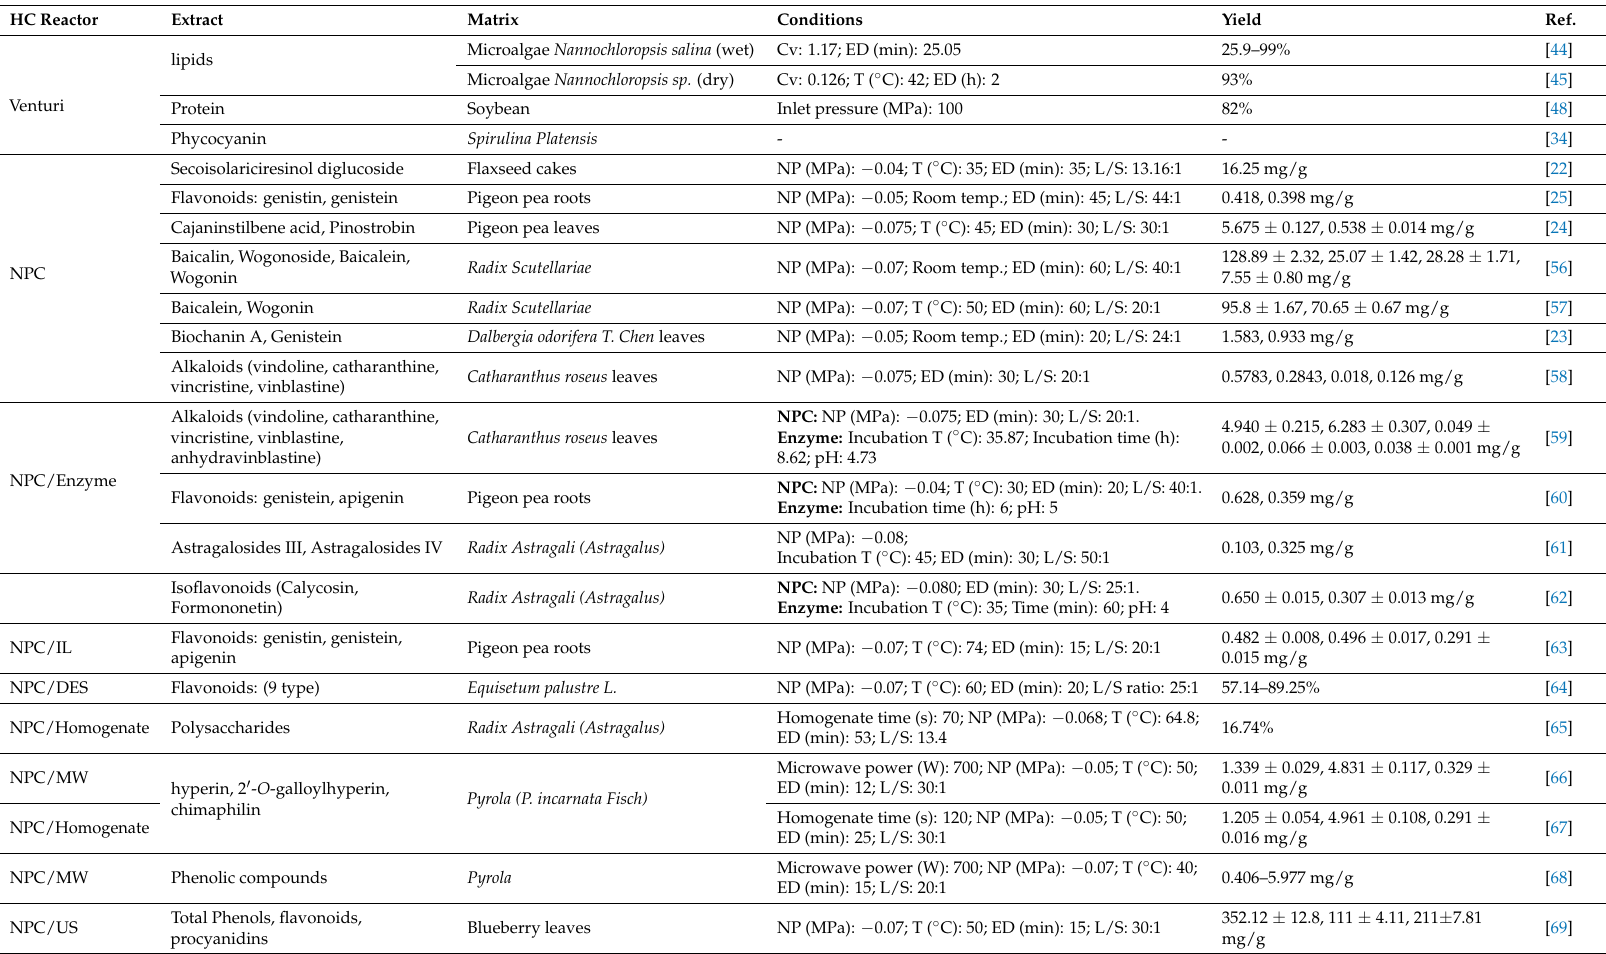
Table 2. HC and NPC assisted extraction of vital